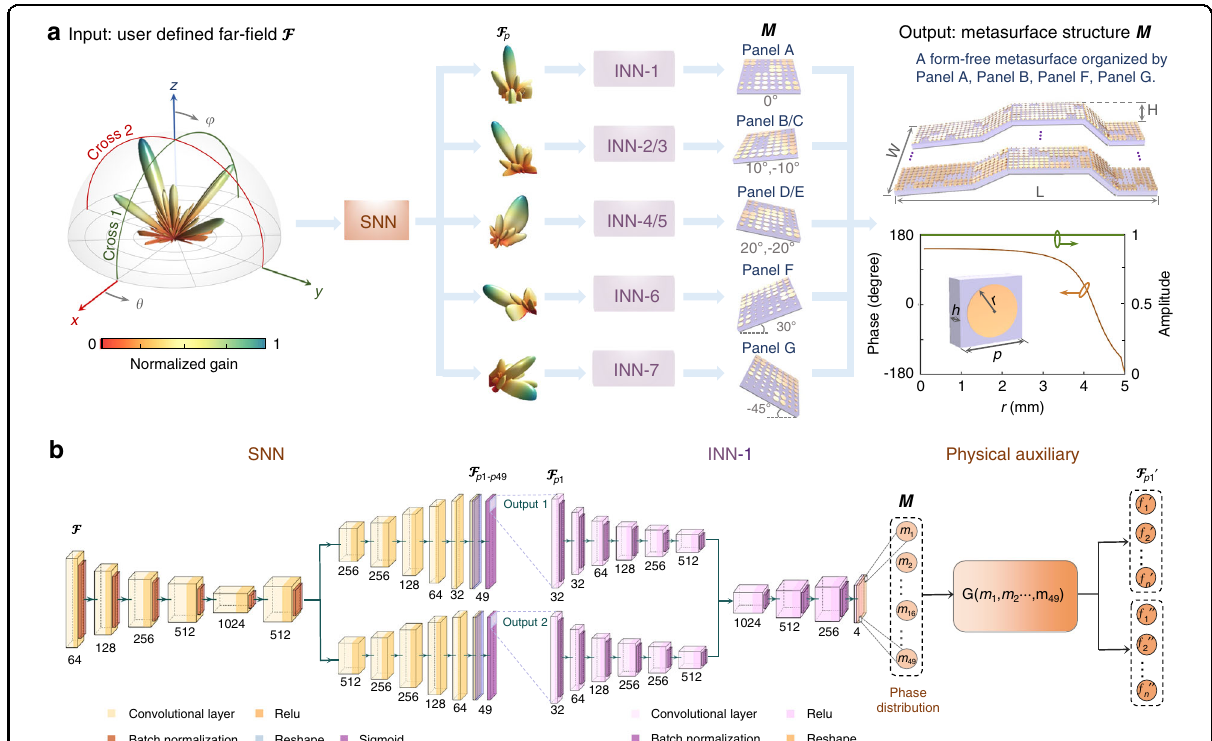
Fig. 2 Design of the knowledge-inherited neural network. a Flowchart of the knowledge-inherited paradigm. To match the inheritance-to- assembly scheme, two networks (INN and SNN) are established, where the INN is responsible for the inverse design of each “ panel ” metasurface, and the SNN aims to explore the relationship between the global target EM response and the local EM response provided by each metasurface panel. For simplicity, we select two cross sections ( xoz , yoz ) of the RCS as input. We build up a data library that contains seven local panels with different tilt angles (tilt in the φ direction), including 0°, ± 10°, ± 20°, -30°, and 45°. The form-free aperiodic metasurface is composed of 49 local panels from Panels A, B, F, and G, with the whole size of W = 539 mm, L = 572 mm, and H ¼ 60mm. The geometrical details and dispersion relation of the meta-atom are presented on the right side, where p ¼ 10mm and h ¼ 2mm. b The structure of the knowledge-inherited neural network. The SNN is a dual- output network comprised of a CNN, and the INN is established as a dual-input dual-output network with two modules, i.e., a CNN module for the inverse design and a physical auxiliary module for the forward mapping (Note that all digital subscripts represent the number of fi lters). They are concatenated by the intermediate phase distribution. More details are discussed in the